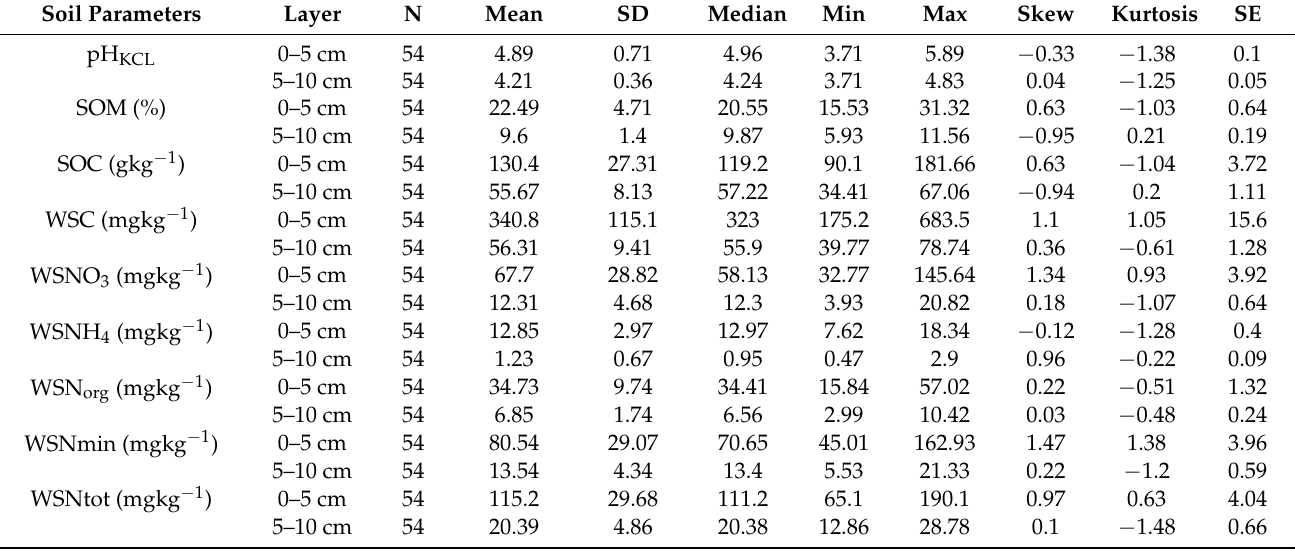
Table A2. Descriptive statistics of soil parameters for two soil layers (0–5 cm and 5–10 cm) across all samples (two samples per plot, eight tree species, one mixed plot) (Rwibasira et al., Long-term effect of forest plantation species on soil chemical properties in Southern